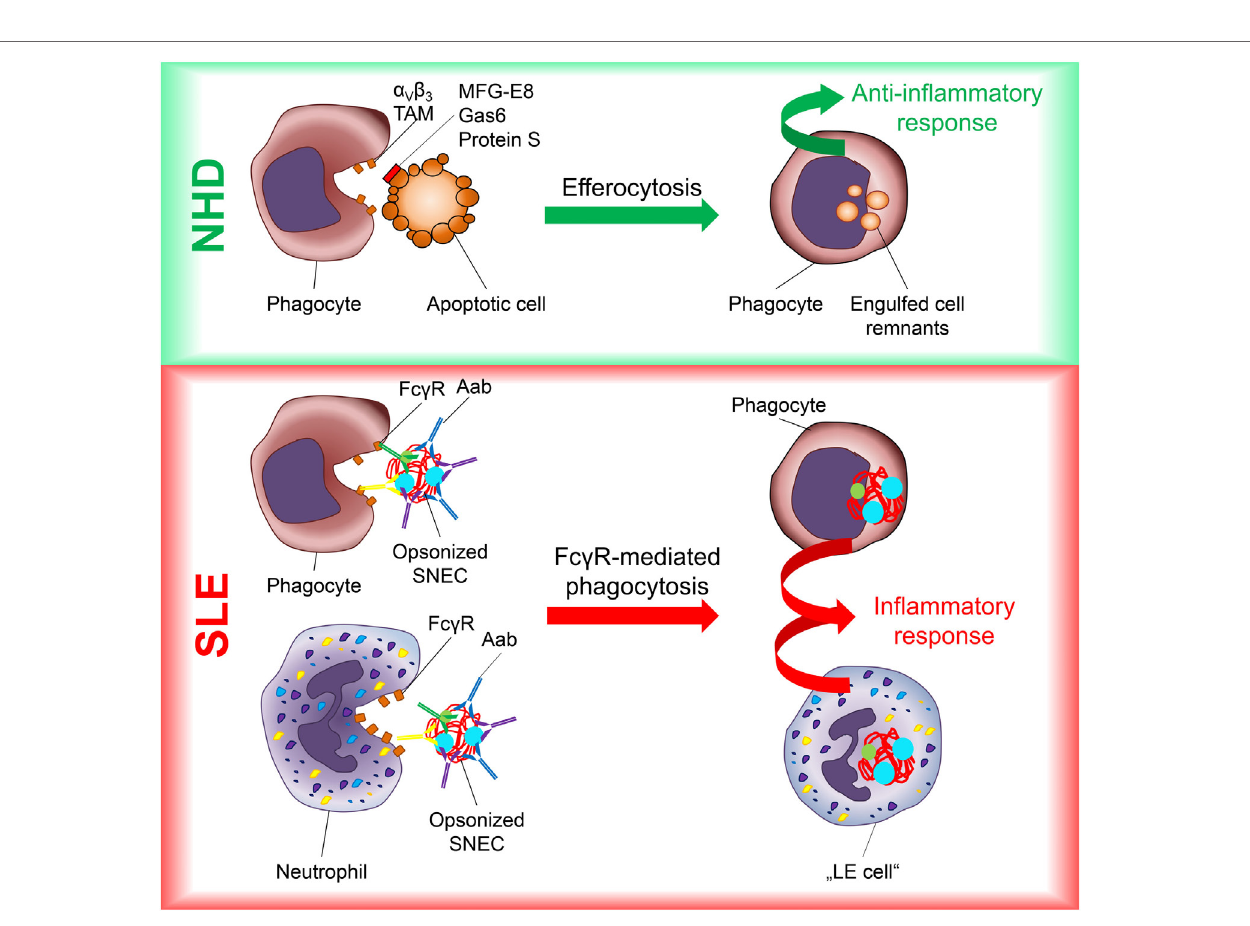
FigUre 4 | Secondary NEcrotic cell (SNEC) positivity correlates with uptake of SNEC into blood-borne neutrophils. (a) Correlation of SNEC uptake by neutrophils assessed by flow cytometry with anti-SNEC IgG. Values are displayed as ranks. Spearman’s rank correlation coefficient was calculated using the values of patients with SLE. (B) Representative microphotographs of z -stack series showing that PI-stained SNEC (red) was taken up by neutrophils with a segmented nucleus (CD15POS; displayed in green; Hoechst 33342POS; displayed in blue). White arrows indicate SNEC taken up by neutrophils. SNEC phagocytosed by a CD15NEG mononuclear phagocyte is indicated by a red arrow. (c) Uptake of PI-stained SNEC by CD16POS HLA-DRNEG granulocytes in whole blood assessed by flow cytometry in the presence ( + SNEC, non-adsorbed) or absence ( + SNEC, adsorbed) of anti-SNEC autoantibodies. CD16POS HLA-DRNEG granulocytes in whole blood without addition of SNEC served as negative control ( − SNEC). Shown is the uptake of SNEC in the presence of a representative adsorbed and non-adsorbed SLE serum. (D) Percentage of SNEC uptake into CD16POSHLA-DRNEG granulocytes in the presence of 10 anti-SNEC antibody adsorbed SLE sera relative to the corresponding non-adsorbed sera. (e) Percentage of residual anti-SNEC IgG in adsorbed relative to the corresponding non-adsorbed sera assessed by SNEC